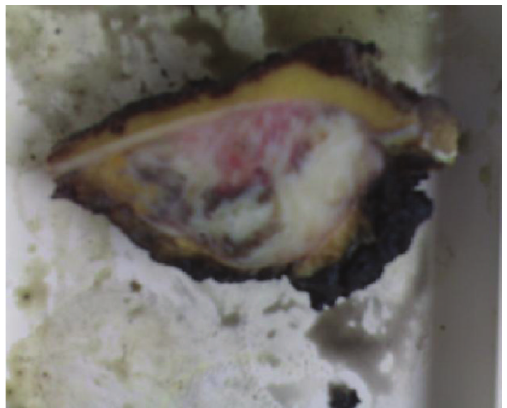
Figure 6: The tumor had minimal focal spread into the medullar canal (less than 10% of total surface) and did not show invasion into the overlying muscles.